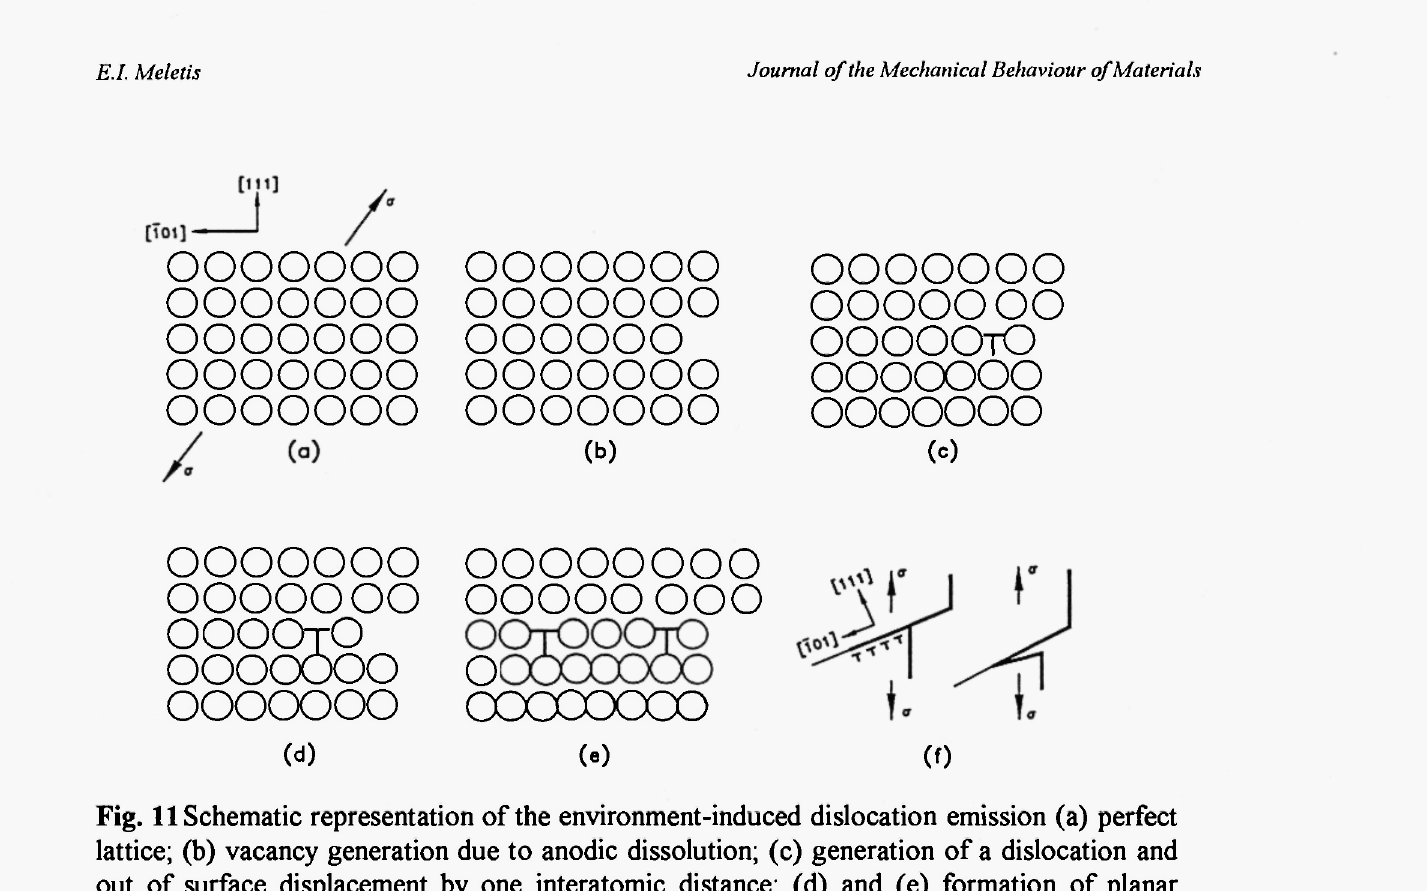
Fig. 11 Schematic representation of the environment-induced dislocation emission (a) perfect lattice; (b) vacancy generation due to anodic dissolution; (c) generation of a dislocation and out of surface displacement by one interatomic distance; (d) and (e) formation of planar dislocation arrangement; and (f) crack nucleation by opening of the dislocation pile-up